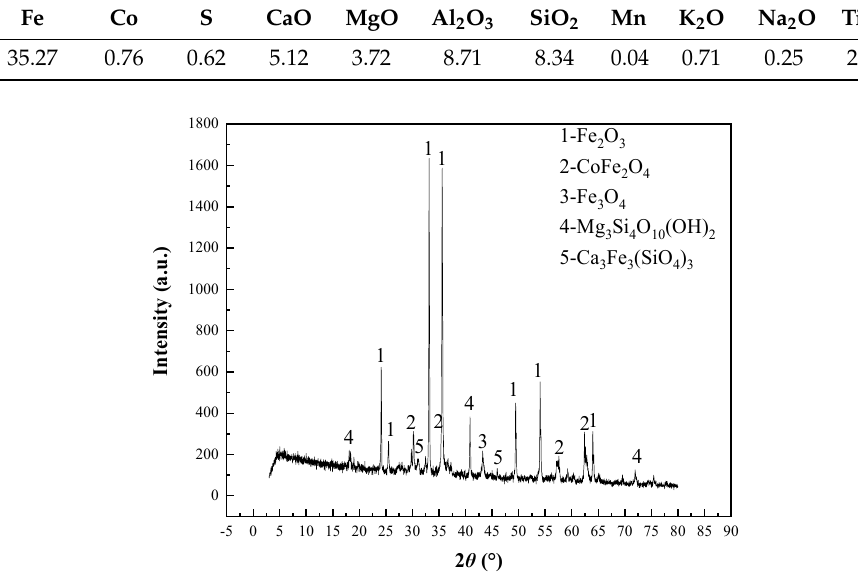
Table 6. Main chemical composition of oxidizing roasting ores (%).